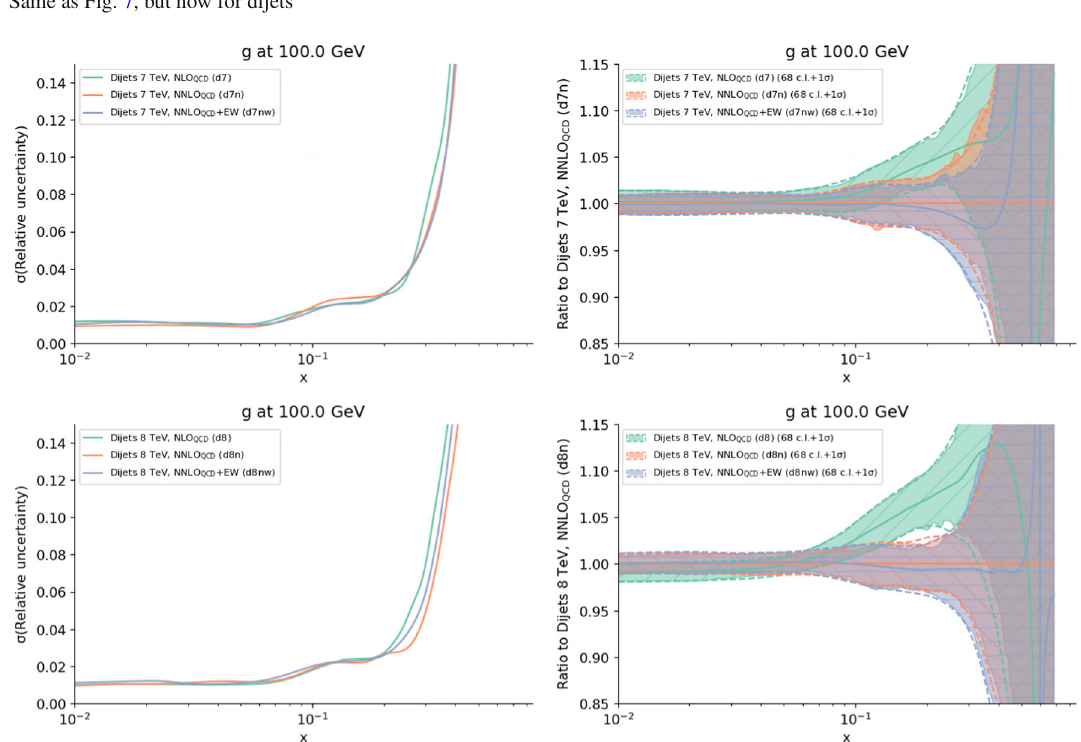
Fig. 15 Same as Fig. 8, but now for